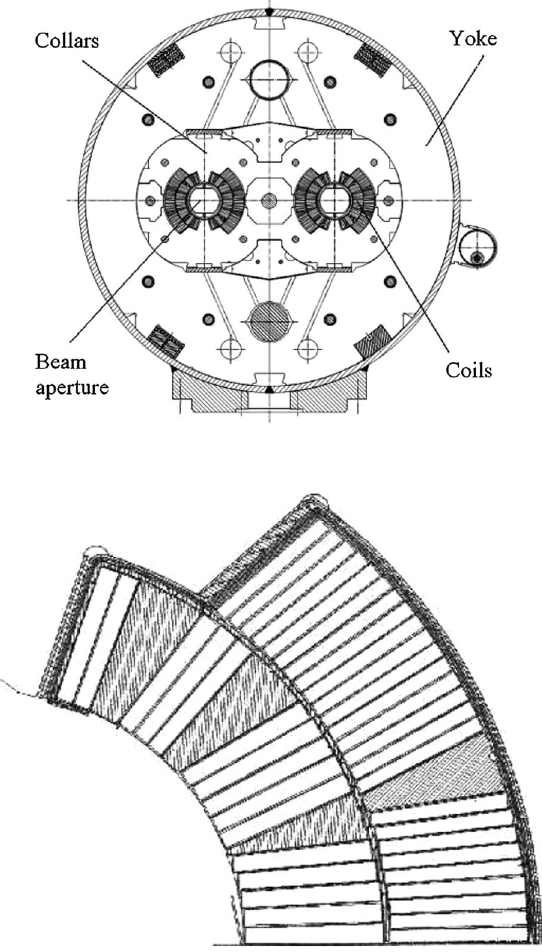
FIG. 1. LHC dipole cross-section (top) and detail of one quarter of the coil (bottom).